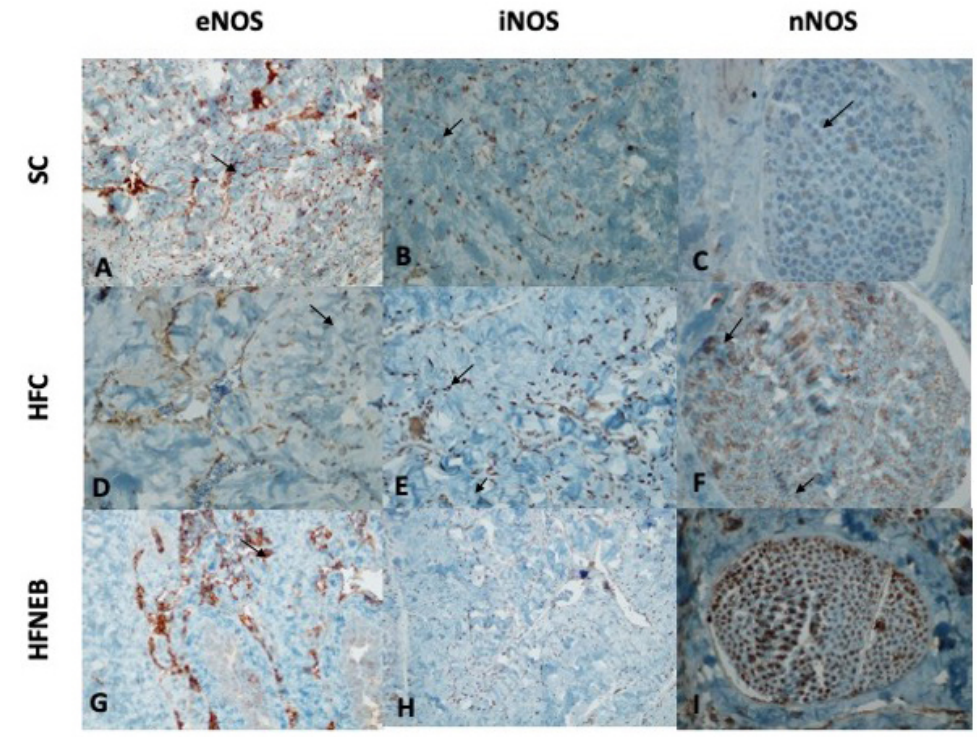
Fig. 6. NOS immunoreactivity of the groups (200x) . Red colouring indicates positive immunostaining (black arrows). The individual panels represent penis sections from SC (A, B, C); from HFC (D, E, F) and from HFNEB (G, H, I) group of animals.